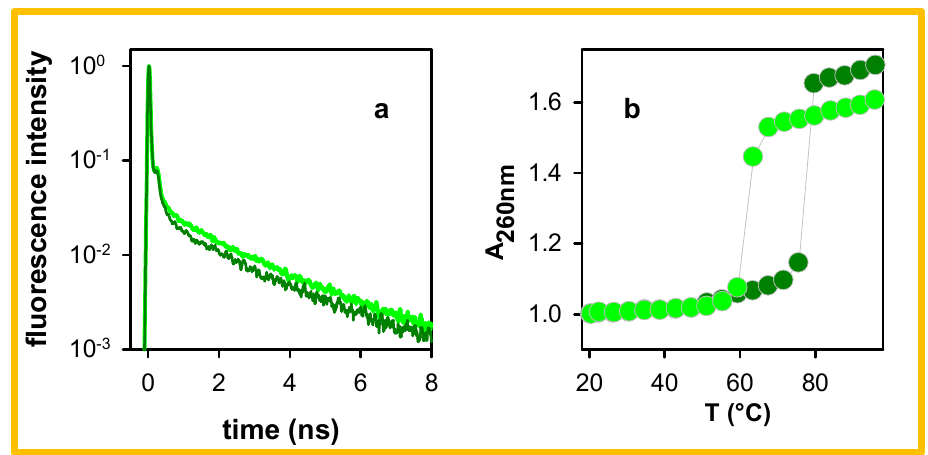
Figure 6. Normalized fluorescence decays at 305 nm ( a ) and melting curves at 260 nm ( b ) recorded for pA • pT in the standard buffer in its nominal concentration (dark green) and diluted by a factor six (light green); excitation wavelength: 285 nm.